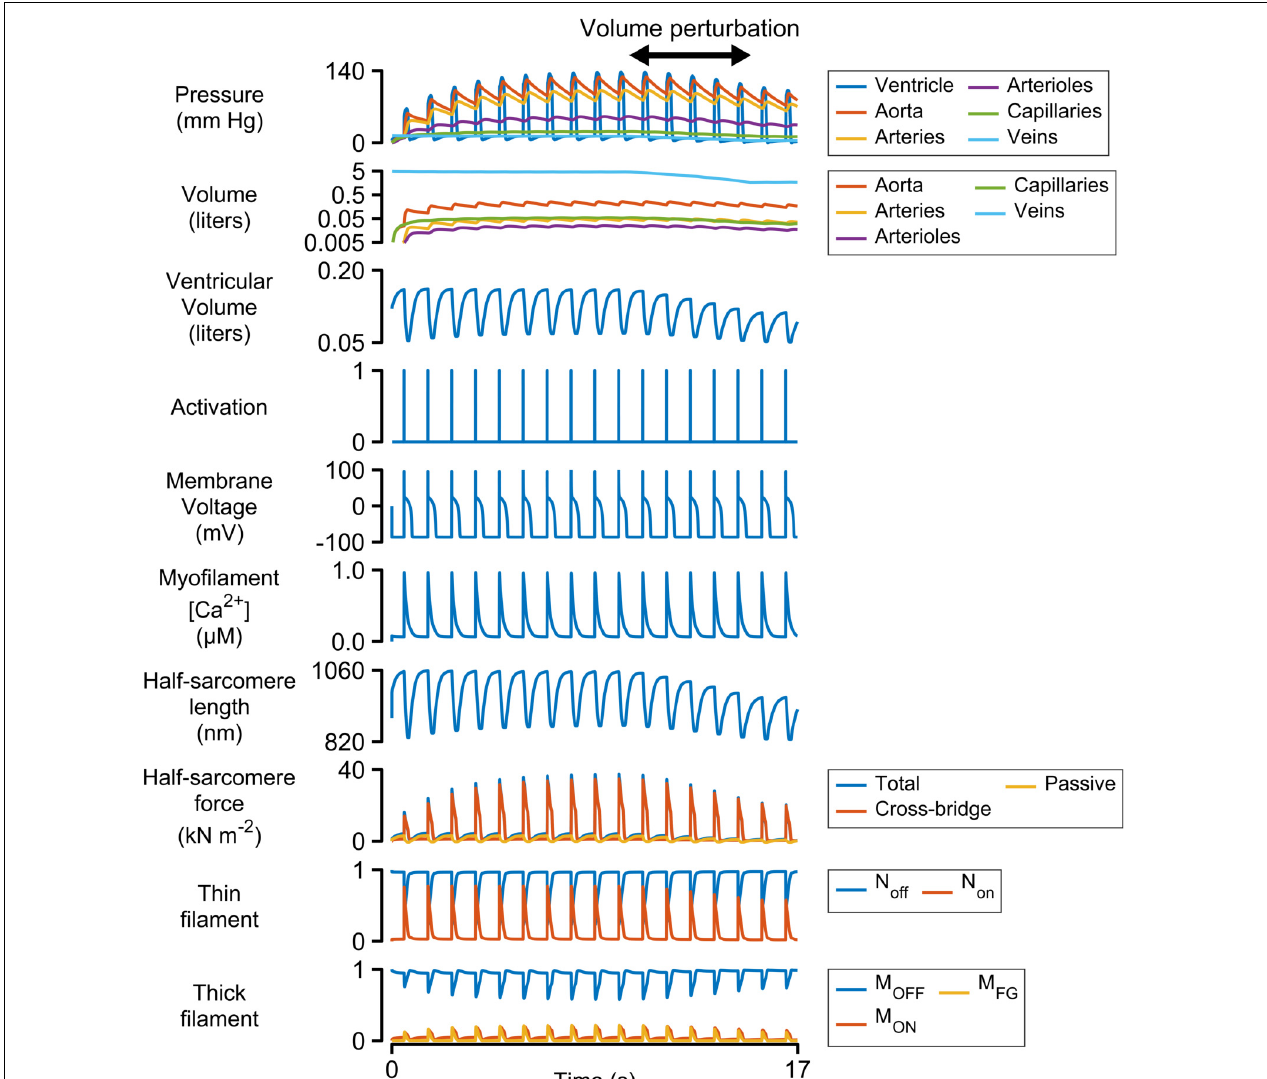
FIGURE 2 | Multiscale simulation of 17 heart-beats. The simulation took about seven beats to reach steady-state as blood was pumped through the systemic circulation. The blood volume was reduced by 60% between the 10th and 15th beats to determine how the ventricle responded to reduced pre-load. The panel showing the volumes of the circulatory compartments is plotted on a log scale. All other panels are plotted with linear